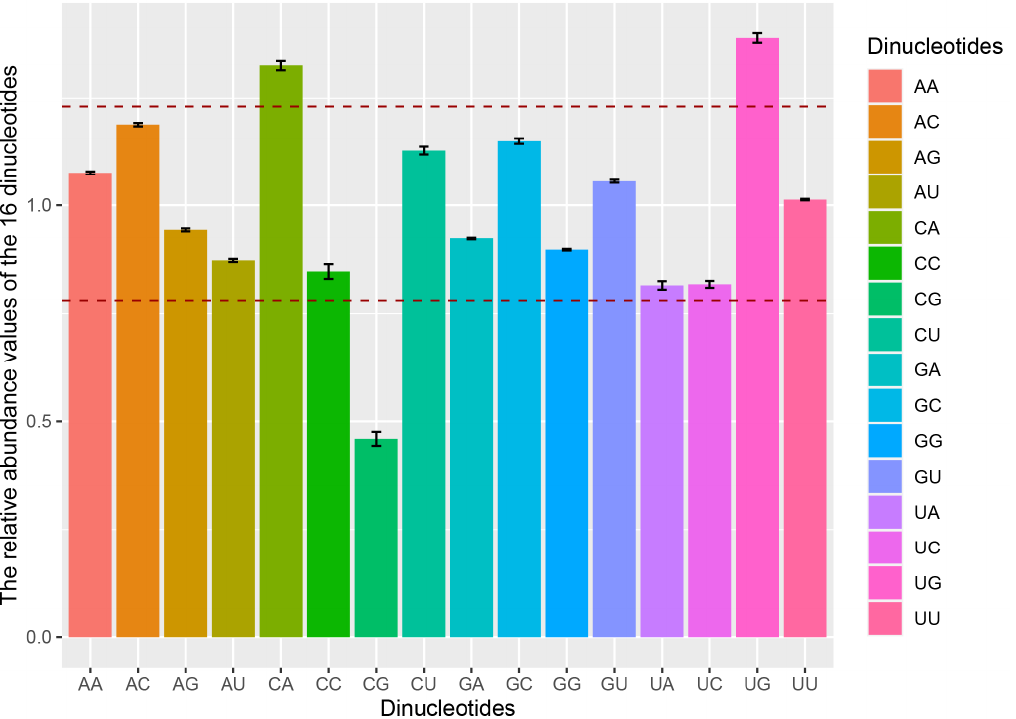
Figure 3. Relative dinucleotide abundance of the complete CDS of TGEV. The above and below dashed lines represent 1.23 and 0.78, respectively.